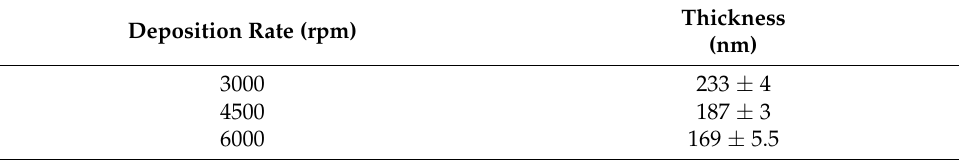
Table 1. R6G:PMMA layer